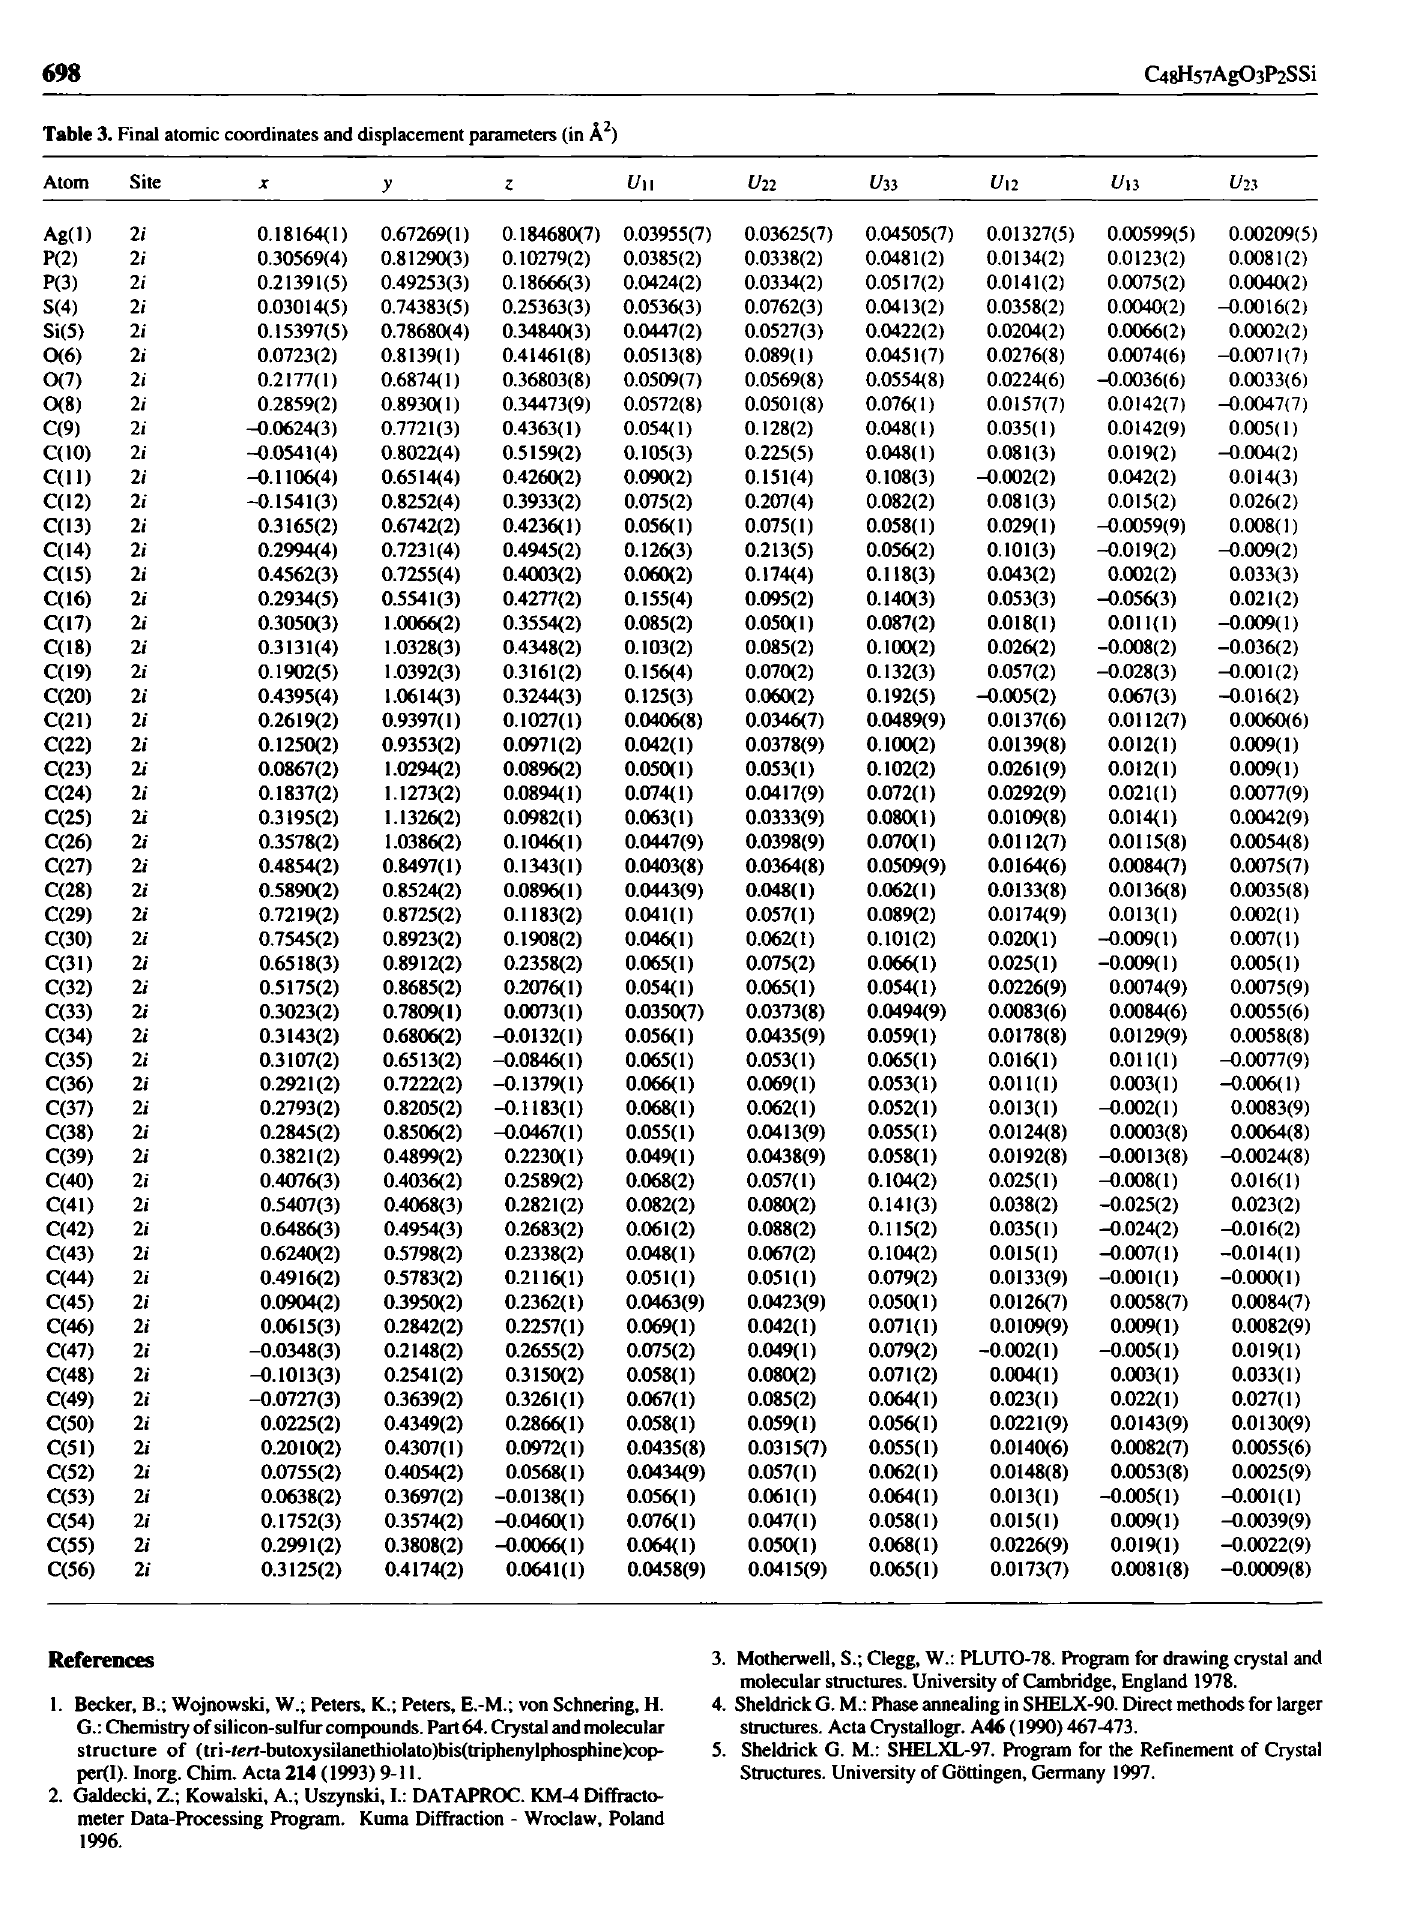
Table 3. Final atomic coordinates and displacement parameters (in